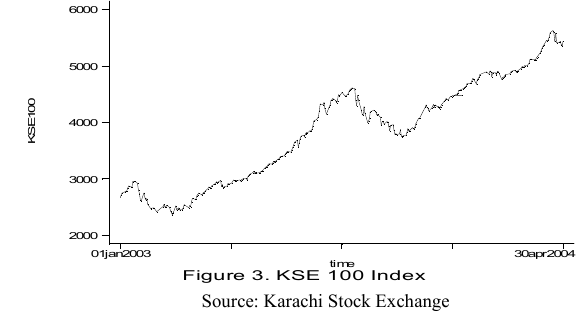
3000400050006000 30apr20042000 time01jan2003 Figure 3. KSE 100 Index Source: Karachi Stock Exchange